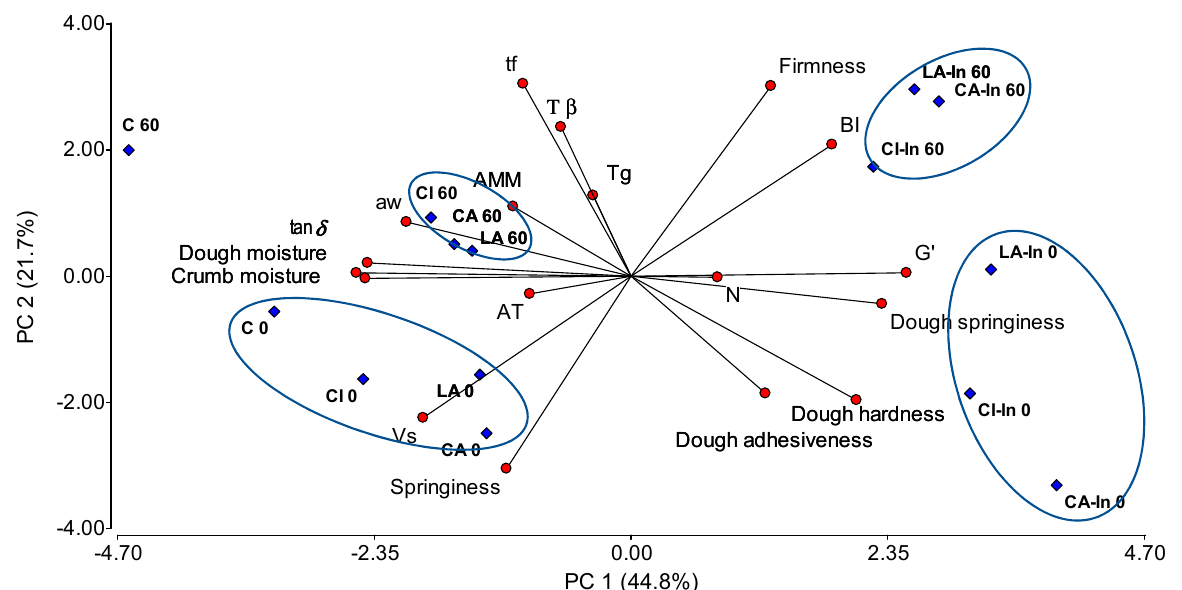
Figure 7. Biplot (PCA) of correlation between fresh and stored doughs at − 18 ◦ C for 60 days and its bread quality .